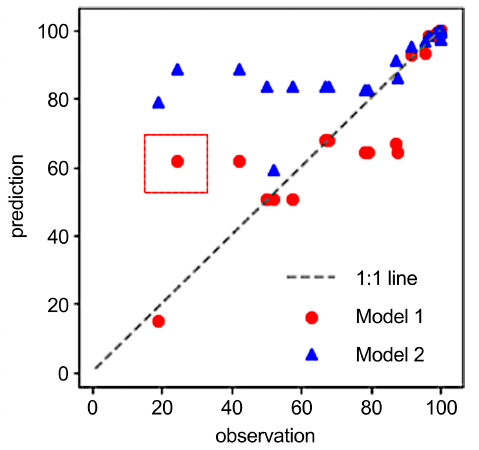
Figure 5. Comparison of the model predictions with the observations.